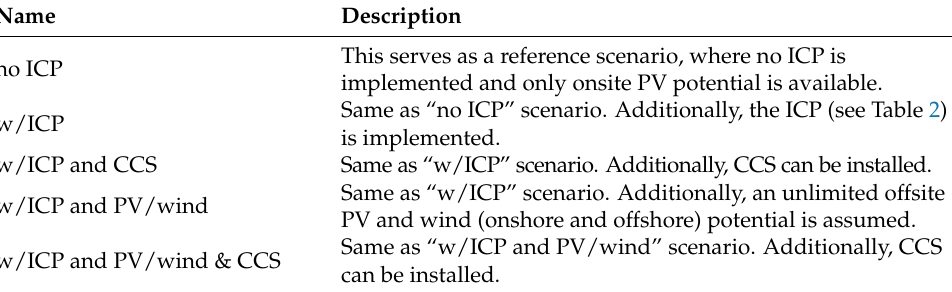
Table 6. Scenario